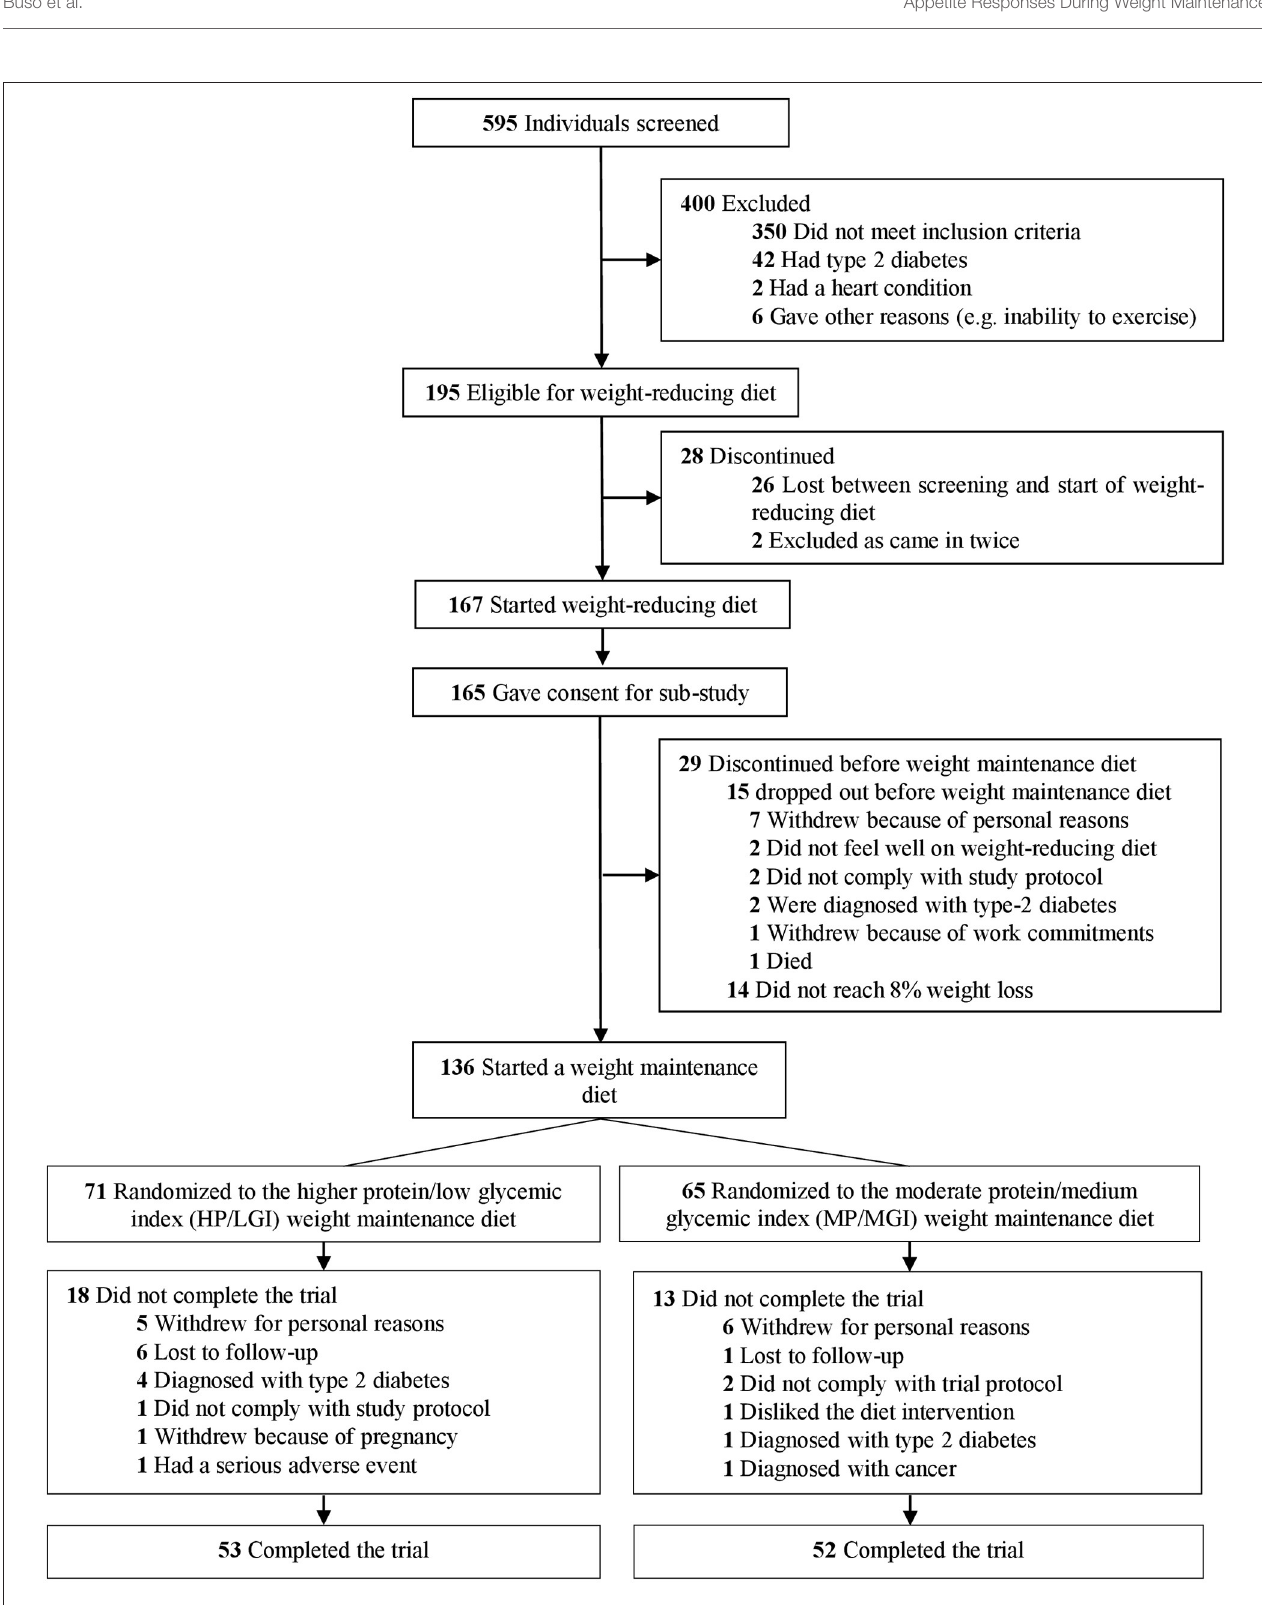
FIGURE 1 | Trial flow diagram. The trial involved a 2-month weight-reducing diet consisting of a total meal replacement diet with a prescribed daily energy intake of 3,400 kJ (800 kcal). As per the registered trial design, participants who lost 8% or more of their initial body weight proceeded to a 34-month weight-maintenance diet involving either a diet with a higher protein (25% of energy) and moderate carbohydrate content (45% of energy) with a low glycemic index ( ≤ 50) (HP/LGI) vs. a diet with a moderate protein (15% of energy) and higher carbohydrate content (55% of energy) with a moderate GI ( ≥ 56) (MP/MGI).